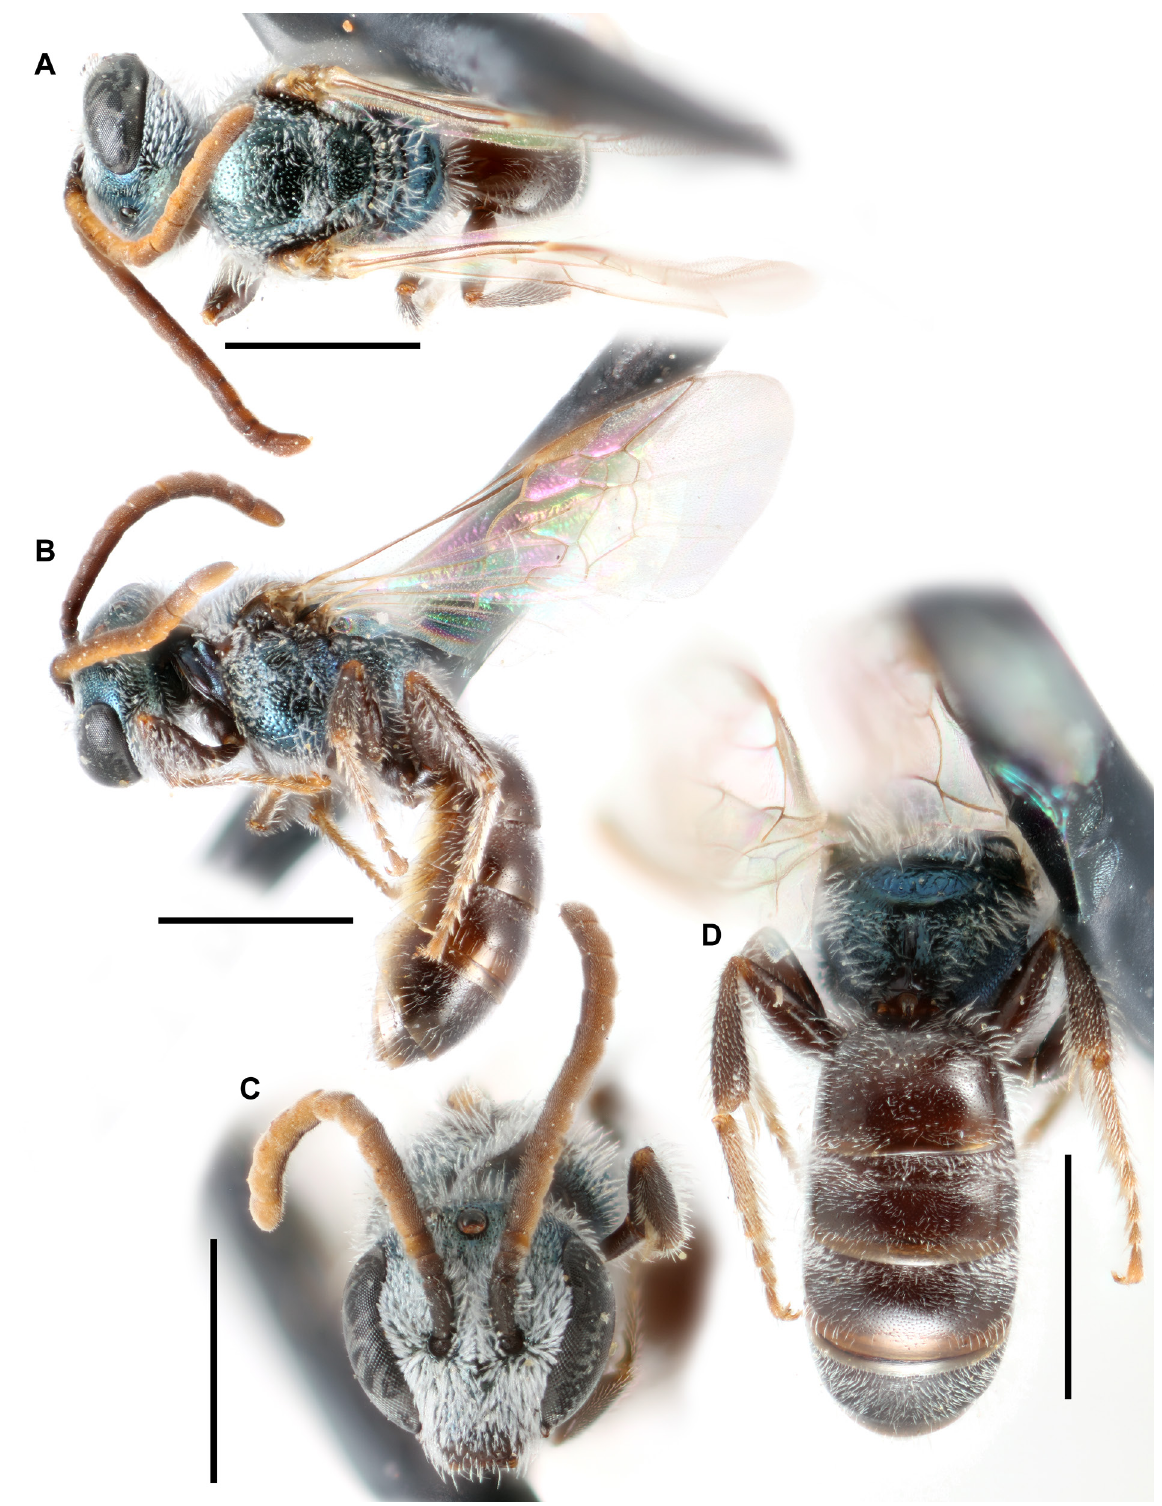
Fig. 13. Lasioglossum ( D .) deludens sp. nov., ♂. A . Dorsal habitus. B . Lateral habitus. C . Face. D . Metasoma and propodeum. Scale bars = 1